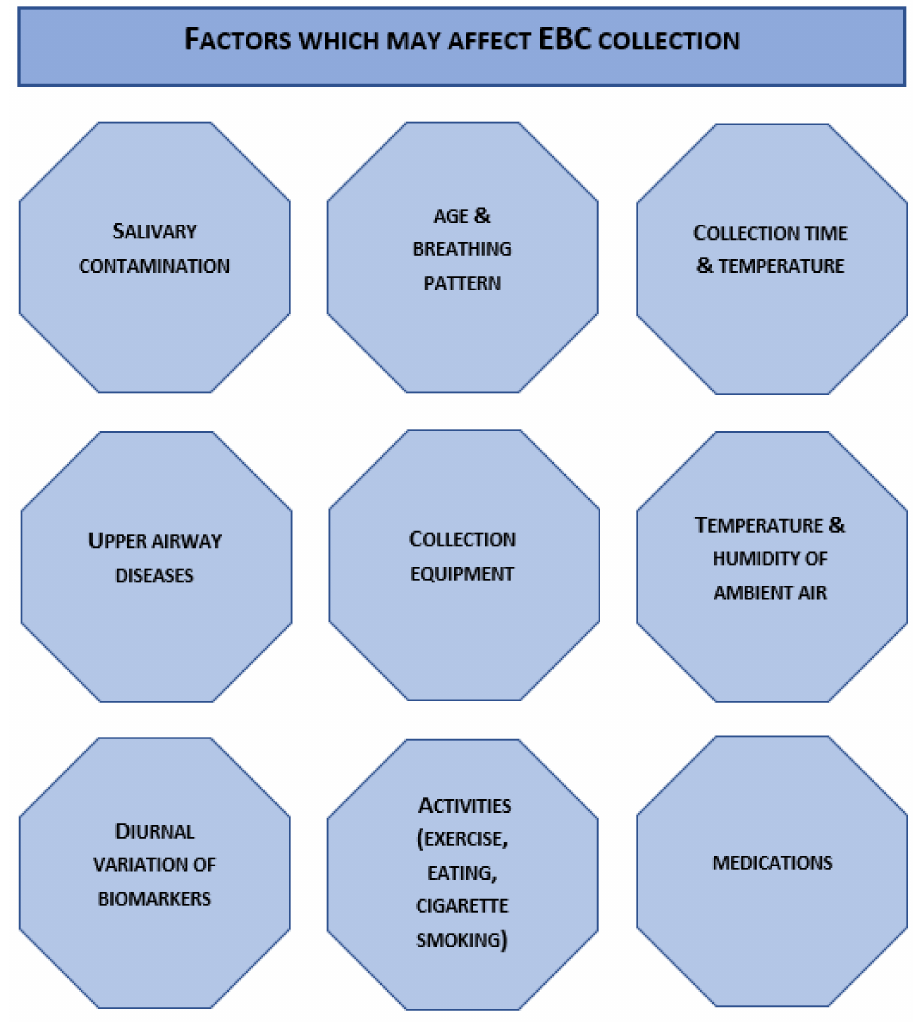
Figure 1. EBC collection influencing